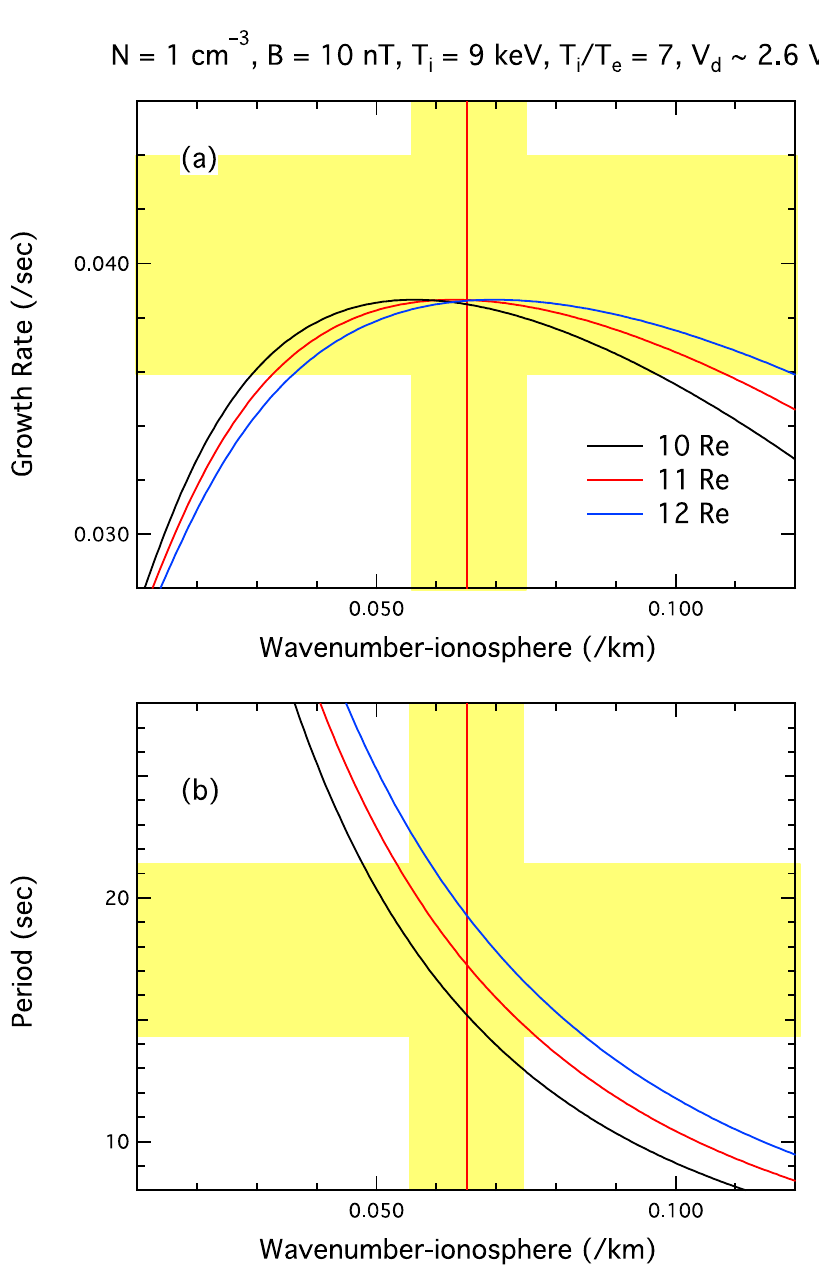
Figure 7. Comparison of observed ( a ) growth rate and ( b ) period as a function of ionospheric wavenumber for WABs with CCI predictions. The comparison shows that the WABs characteristics can be produced best by excitation of CCI at 11 R E for the local plasma parameters as shown.